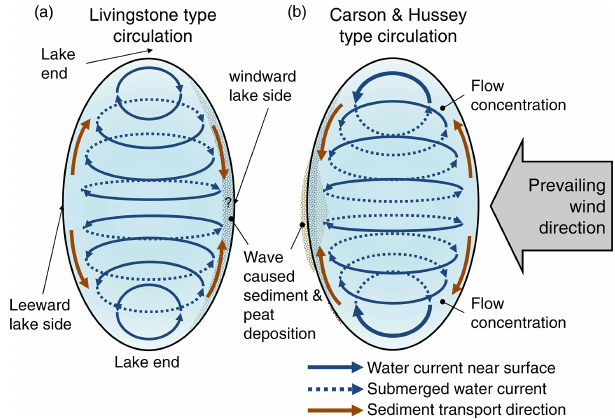
Figure 8. Two distinctive lake water circulation patterns created by unidirectional wind. Livingstone-type circulation (a) and Carson and Hussey (CandH)-type circulation (b) cause opposite flow direc- tions around lake ends. This also results in differences in sediment and peat deposition patterns.